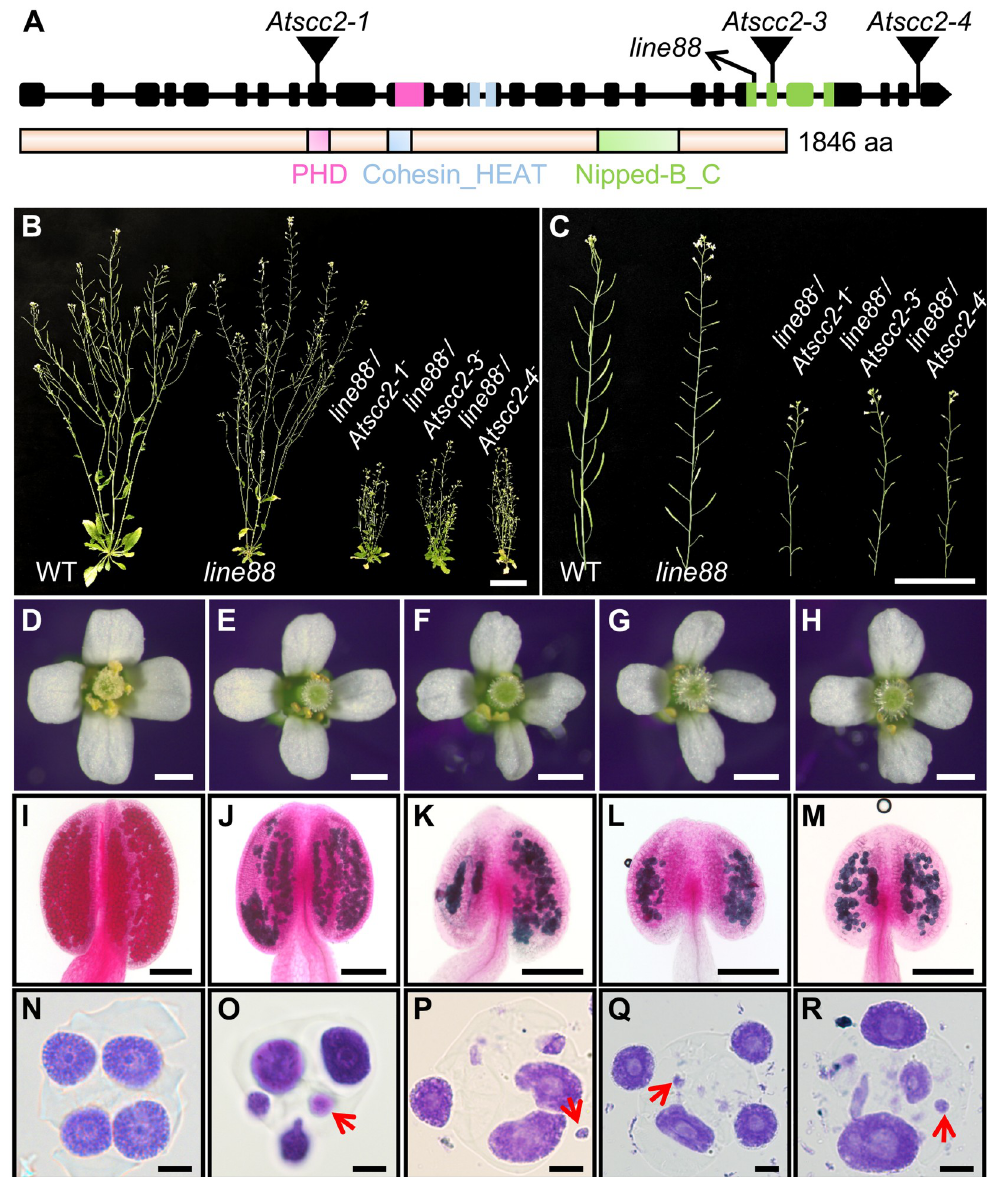
Fig 1. Identification of Atscc2-5 . (A) A diagram of AtSCC2 gene and AtSCC2 protein structure. Mutant alleles are marked above the gene structure (inverted triangles and diagonal arrow). (B) WT, line88 and three compound heterozygous mutants of line88 with individual Atscc2 alleles. Bar = 3 cm. (C) Primary stems of WT, line88 and three compound heterozygous plants. Bar = 3 cm. (D-H) Open flowers of WT, line88 and three compound heterozygous plants. Bar = 0.5 mm. (I-M) Alexander staining of WT, line88 and three compound heterozygous plant anthers. Bar = 100 μ m. (N-R) Toluidine blue staining of tetrad-stage microspores of WT, line88 and three compound heterozygous plants. Red arrows indicate the abnormal micronucleus in tetrad stage. Bar = 5 μ